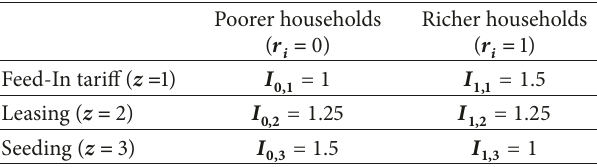
Table 2: Incentive parameter values 𝐼 ( 𝑟 𝑖 , 𝑧 ) by incentive program and agent type Poorer